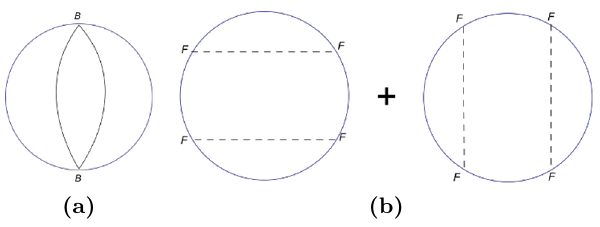
Figure 2 . Two-loop Feynman